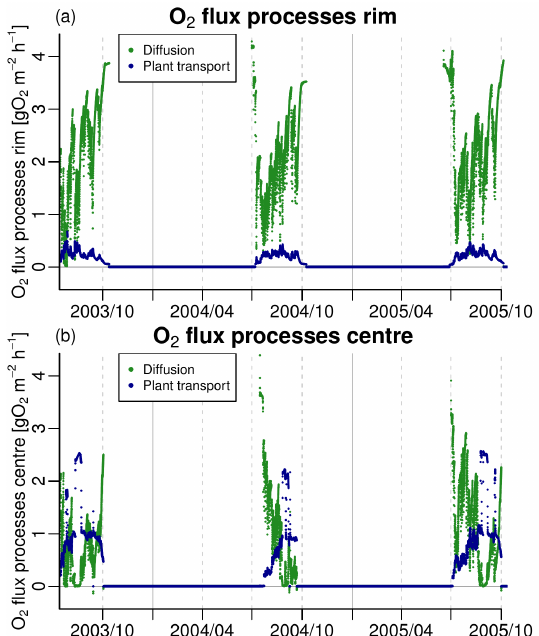
Figure B7. Modelled oxygen flux into soil at the (a) rim and (b) centre, split into the different transport processes. Solid lines indicate 1 January; dashed lines indicate 1 April, 1 July and 1 Oc- tober of the respective year. Because of the wide spread of high values, to as high as 16.3 (a) and 14.4 (b) g O 2 m − 2 h − 1 , a portion of 0.0254% (a) and 0.0178% (b) values was cut to provide rea- sonable pictures. The minima of the values are − 0 . 00185 (a) and − 2 h − 1 − 0 . 136 (b) g O 2 m